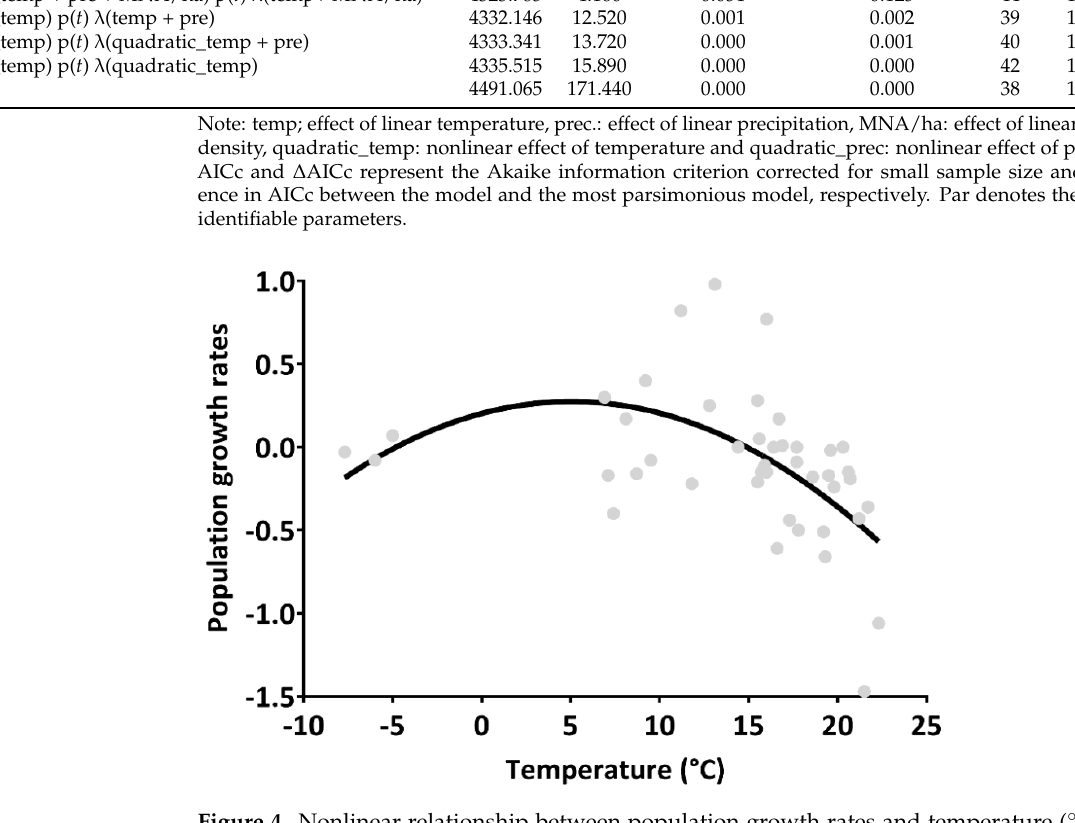
Table 2. Complex effects of temperature (°C), precipitation (mm), and population density on popu-